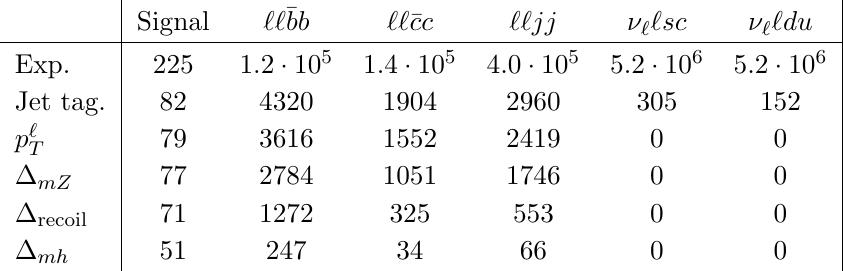
Table 4. Cut(cid:13)ow table for the signal and relevant backgrounds in the charged lepton channel at 250 GeV with polarisation sharing scenario 1 and 2 ab (cid:0) 1 of integrated luminosity. For the signal we have assumed ( h bs ) 0 : 73 %. B ! ’